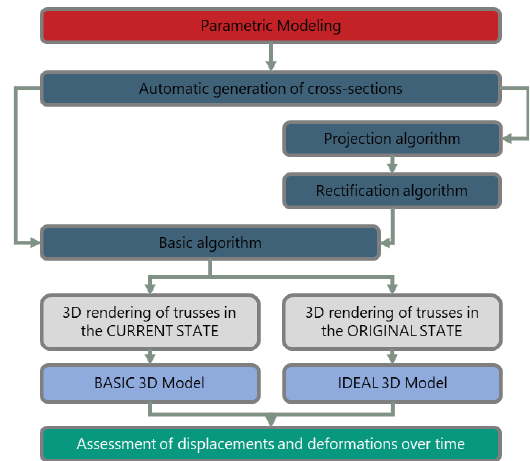
Figure 3: Parametric modeling procedure workflow